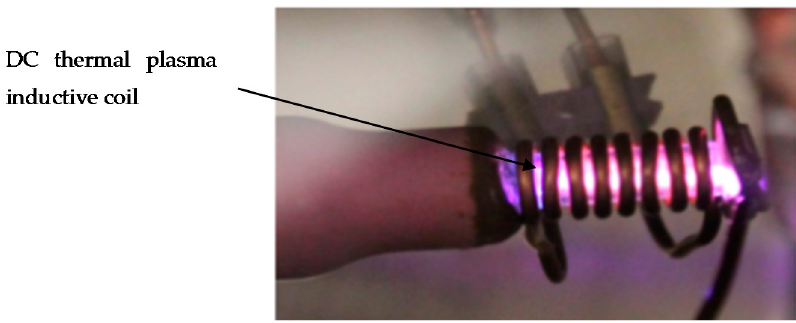
Figure 9. DC generation over a ceramic nozzle.